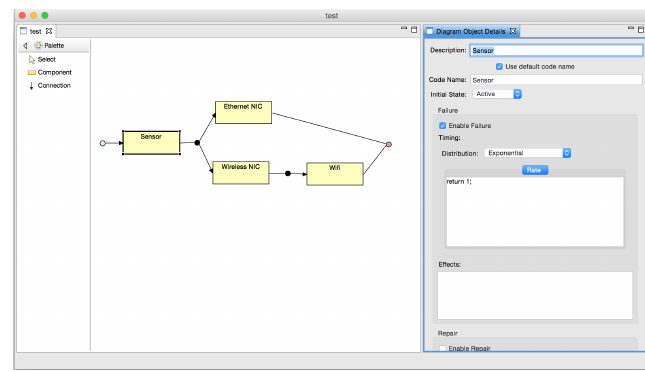
Figure 1: An example of the RBD atomic model